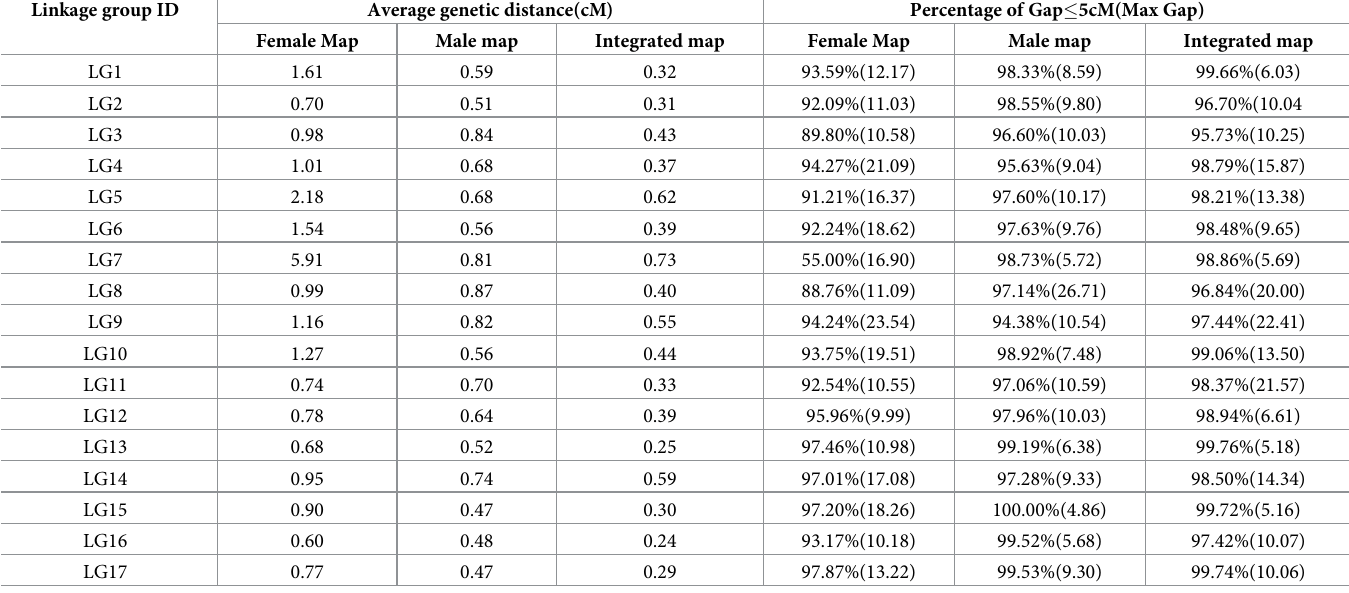
Table 3. Average genetic distance of adjacent markers in 17 linkage